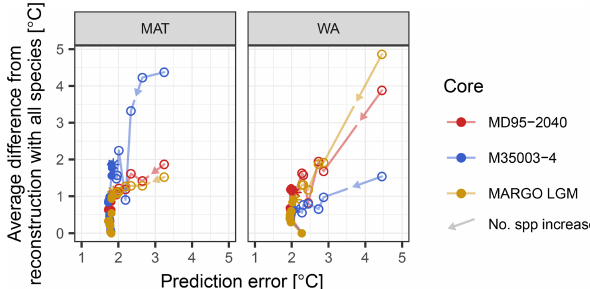
Figure 6. General effect of species pruning on reconstructions and on the prediction error. Each dot represents a reconstruction with n species and its associated prediction error; arrows indicate the direction of increasing species numbers and decreasing species im- portance. The first point details a transfer function model with two species, and one species is added at each subsequent point. Open symbols highlight reconstructions with the essential species, the in- clusion of which leads to a reduction in the prediction error. The re- construction with minimum error and a minimum number of species is marked by a star. All other reconstructions are plotted as dots. Note that for MAT and WA the inclusion of the essential species leads to a reduction of the prediction error, but once these species are included there are still multiple reconstructions with the same error possible.